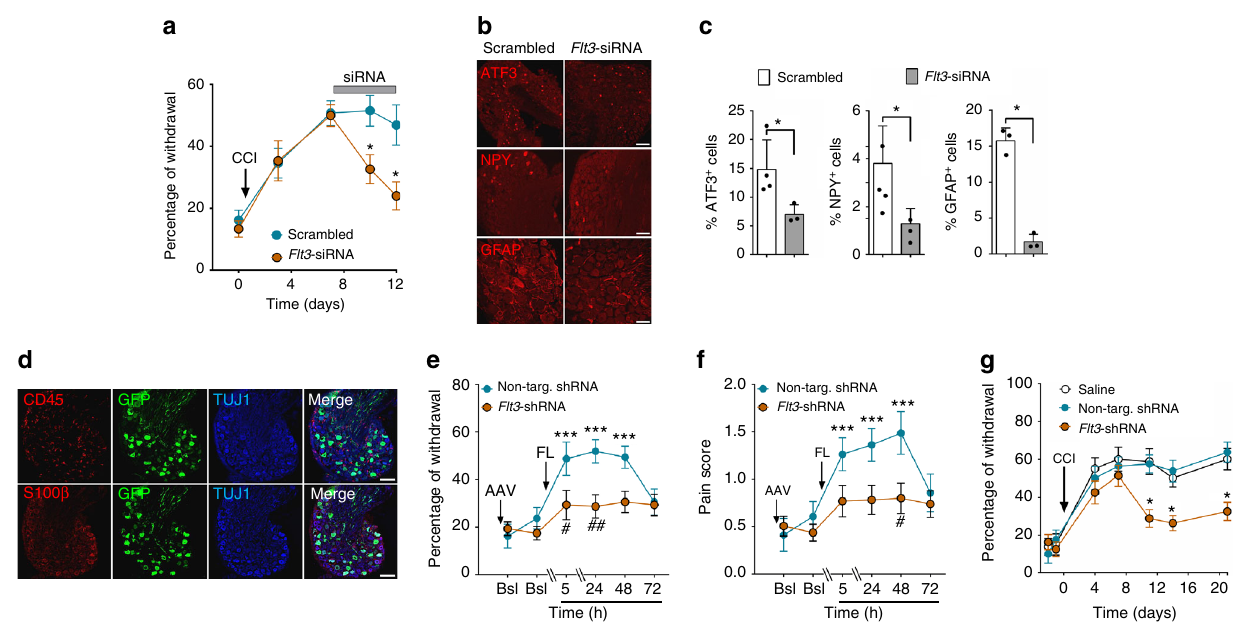
Fig. 5 Curative effects of Flt3 downregulation on PNP-related genes, and nerve injury-induced and FL-induced pain hypersensitivity. a Mechanical pain hypersensitivity after intrathecal infusion for 4 days of scrambled- or Flt3 -siRNA in CCI mice. Means ± s.e.m. of data from 8 animals. Two-way ANOVA and Dunnett ’ s test, * P < 0.05 vs. Scrambled siRNA animals. b ATF3, NPY, and GFAP immunoreactivity in lumbar DRG after intrathecal infusion for 4 days of scrambled- or Flt3 -siRNA in CCI mice. Bars = 100 µ m except for GFAP: 50 µ m. c Quanti fi cation of experiments as in b . Means± s.e.m. of data from 4 animals. Mann – Whitney t -test, * P < 0.05. d Localization of the AAV9 virus expressing anti- Flt3 shRNA and GFP in neurons (TUJ1-positive cells), but not in CD45- or S100 β -positive cells in DRG of WT mice. Scale bars = 100 µ m. e , f Effects of Flt3 -shRNA on FL-induced mechanical pain hypersensitivity ( e ), and on pain-related behaviors ( f ). FL (500 ng/10 µ l) was injected intrathecally 17 days after the virus. Means ± s.e.m. of data from 8 animals. One-way ANOVA and Dunnett ’ s test, * P < 0.05; ** P < 0.01; *** P < 0.001 vs. Bsl; two-way ANOVA with repeated measures and Dunnett ’ s test, # P < 0.05 vs. non-targeting shRNA. g Effects of Flt3 -shRNA on mechanical pain hypersensitivity in CCI mice. The virus was injected intrathecally 48 h before CCI. Means ± s.e.m. of data from 8 animals. Two-way ANOVA with repeated measures and Dunnett ’ s test, * P < 0.05 vs. non-targeting